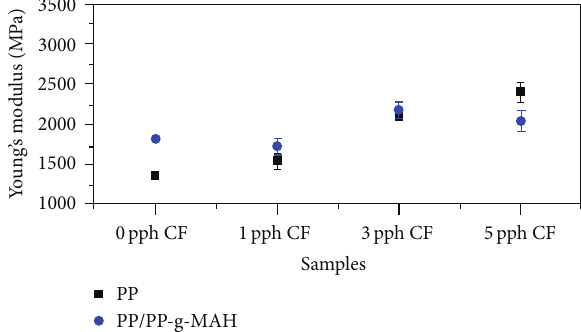
Figure 3: Young’s modulus of compression moulded